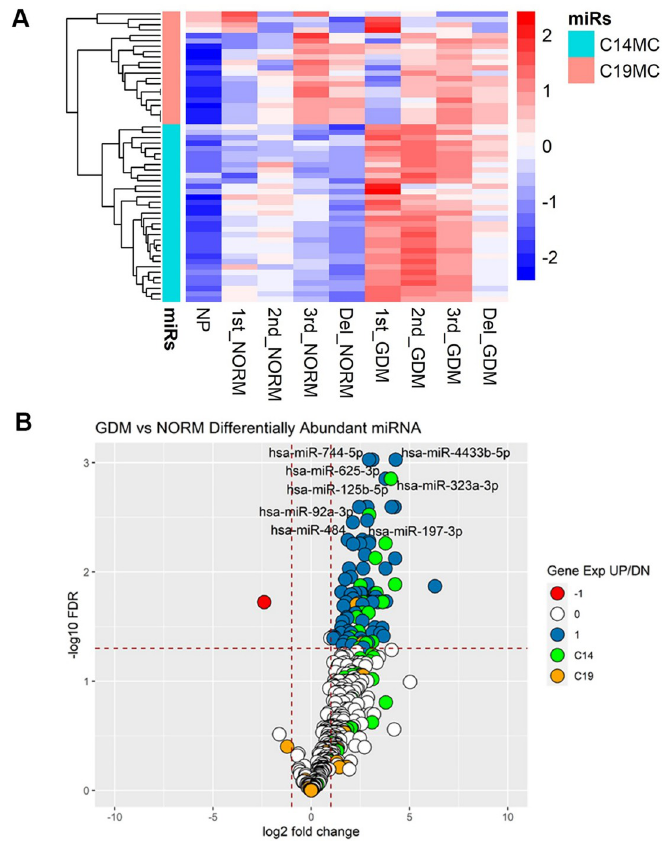
Fig 5. Differential abundance of EV-derived miRNAs in gestational diabetes mellitus (GDM) pregnancies. Heatmap showing expression of placenta-specific C19MC and C14MC in EVs isolated from non-pregnant women (NP), and during 1 st , 2 nd , 3 rd trimesters and at delivery (del) in normal pregnancy (NORM) and gestational diabetes (GDM) (A). Volcano plots display miRNAs from EVs isolated from gestational diabetes mellitus (GDM) (B) compared to normal pregnancies, during the first trimester of pregnancy. Red dots represent downregulated miRNAs, white dots represent miRNAs that are not significant for differential expression, blue dots represent upregulated miRNAs, green dots represent miRNAs from the C14MC and orange dots represent miRNAs from the C19MC.